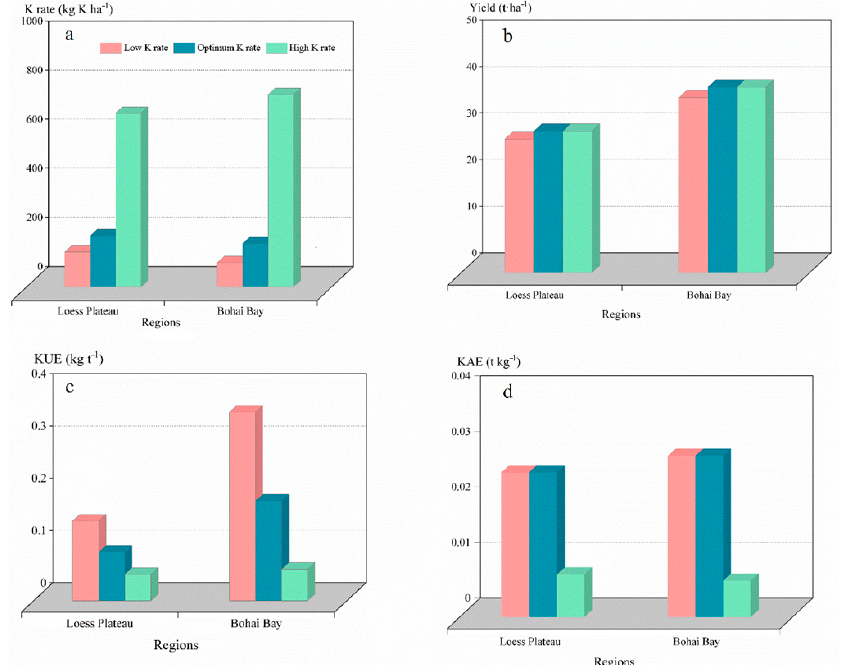
Figure 5. K rate ( a ) apple yield, ( b ) K use efficiency (KUE), ( c ) and agronomic efficiency of K (KAE), ( d ) under three K-fertilizer levels (low K rate, optimal K rate and high K rate) in apple planting regions of China’s Loess Plateau and Bohai Bay.